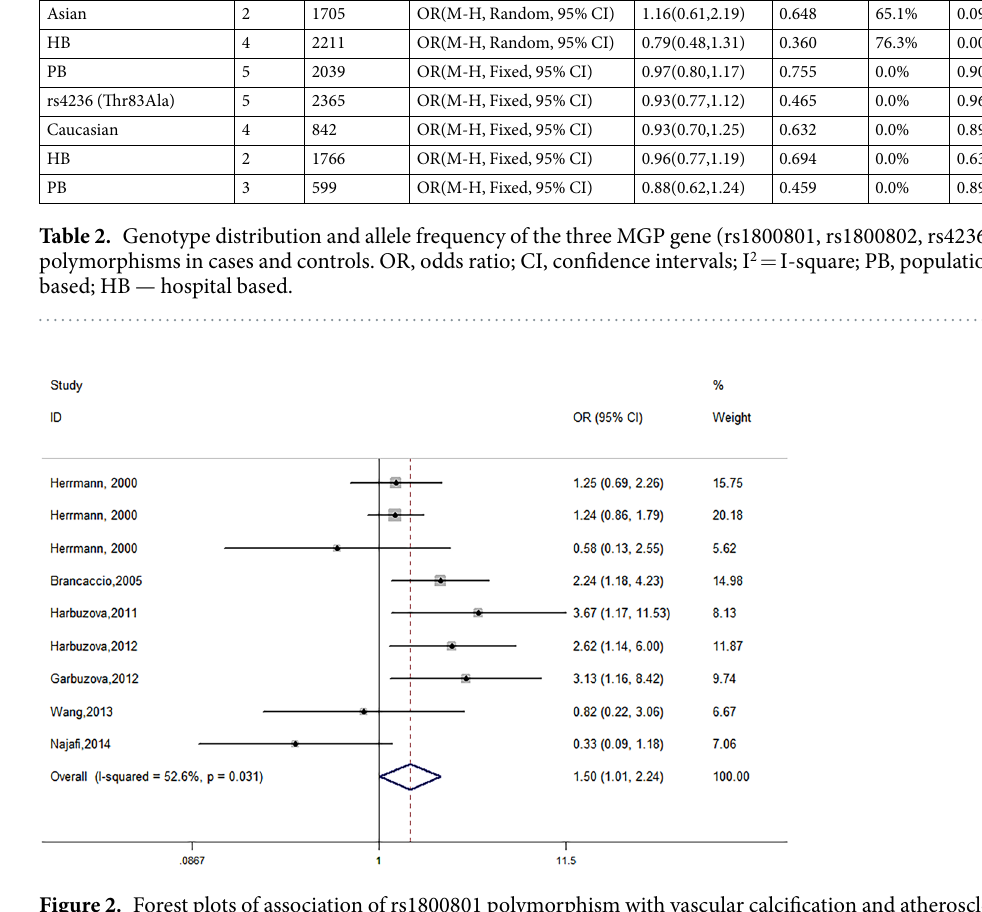
Figure 2. Forest plots of association of rs1800801 polymorphism with vascular calcification and atherosclerotic disease in recessive model.